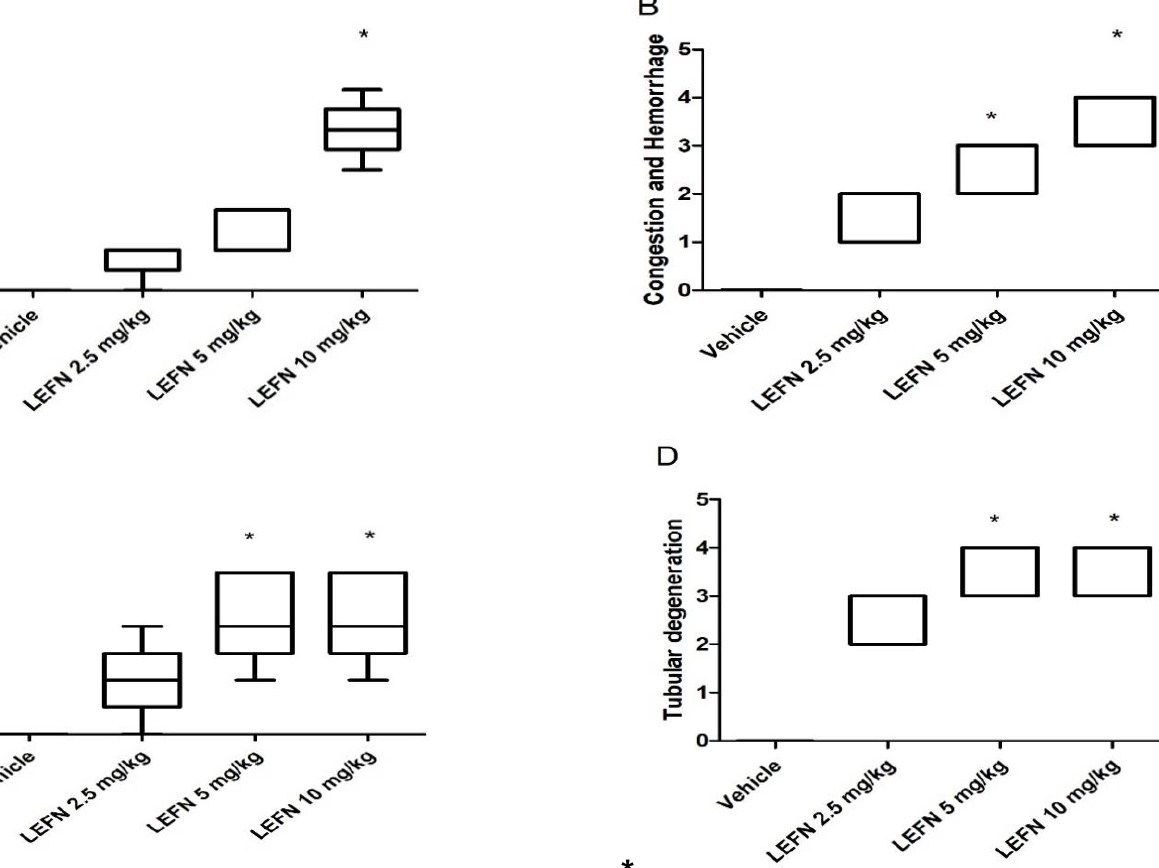
Figure 5. Histopathologic scores for hematoxylin and eosin-stained kidney specimens in mice treated with LEFN. Scores for ( A ) lymphocytic infiltrate, ( B ) congestion and hemorrhage, ( C ) glomerular degeneration, and ( D ) tubular degeneration. A score from 0–5 was given to each sample, and scores are presented as medians and quartiles, and compared by Kruskal–Wallis ANOVA and Dunn’s test at p < 0.05. *: versus the vehicle group.